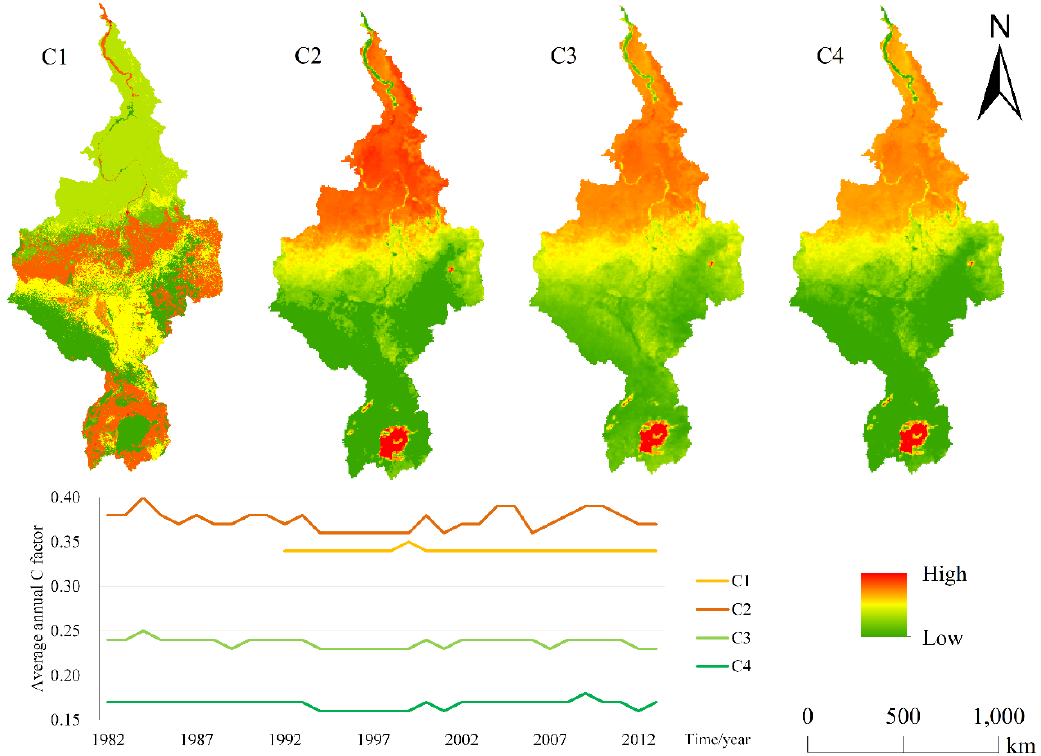
Figure 4. Spatiotemporal characteristic map of the average annual C factor (C1–C4) from 1982 to 2013. C1–C4 represent the four C factor estimation methods shown in Table 2.